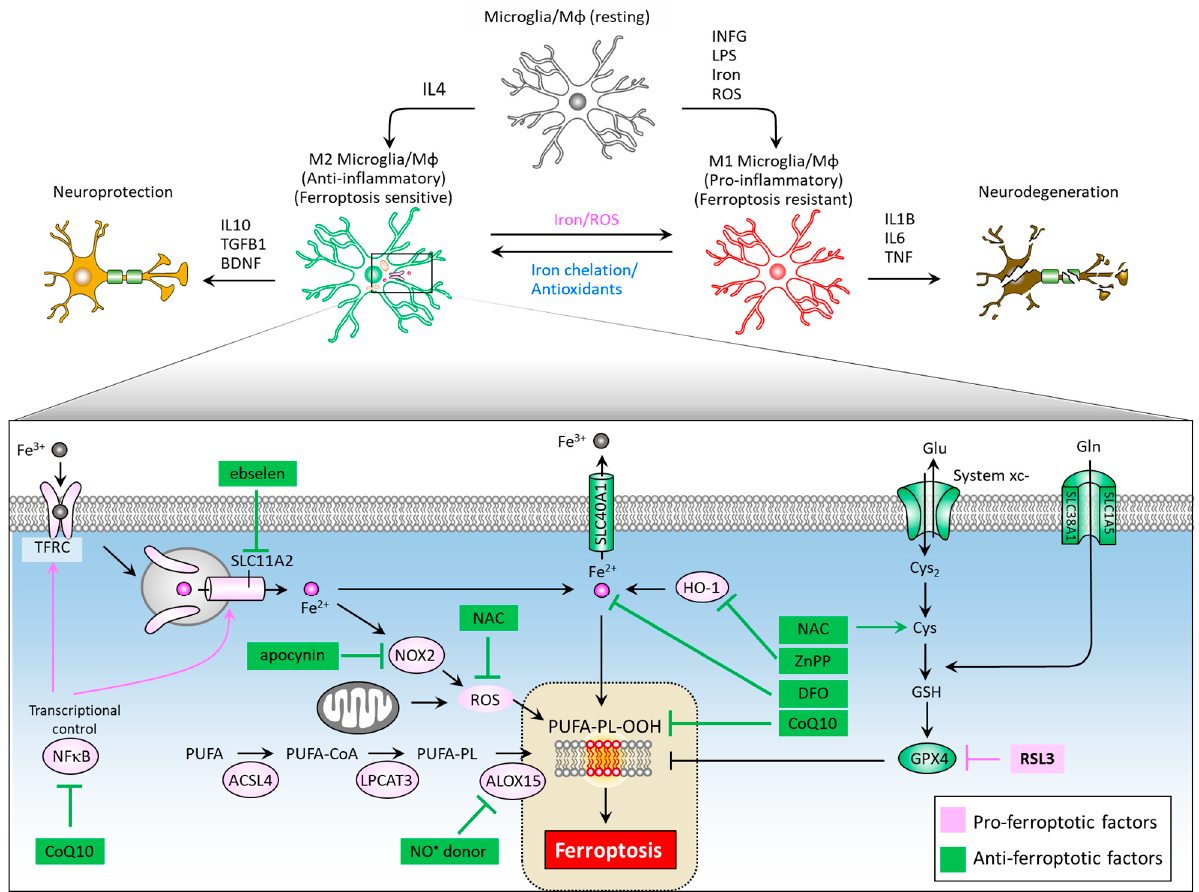
Figure 4. Ferroptosis-associated molecules at the crossroad of microglia/macrophage M1/M2 polarization and neuroin- flammation. While M1 microglia feature ferroptotic resistance, M2 microglia are vulnerable to ferroptosis. Therapeutic targets to reduce iron accumulation, scavenge ROS, and impede the formation of lipid peroxides could provide new hope in the treatment of PD and neurodegenerative disorders. ACSL4, acyl-CoA synthetase long chain family member 4; ALOX15, arachidonate 15-lipoxygenases; BDNF, brain derived neurotrophic factor; CoQ10, coenzyme Q10; Cys, cysteine; Cys2, cystine; DFO, desferoxamine; DHO, dihydroorotate; DHODH, dihydroorotate dehydrogenase; Gln, glutamine; Glu, glutamate; GPX4, glutathione peroxidase 4; GSH, glutathione; HO-1, heme oxygenase-1; IFNG, interferon gamma; IL1B, interleukin-1 beta; IL4, interleukin-4; IL10, interleukin-10; LPS, lipopolysaccharide; M ϕ , macrophage; NAC, N-acetylcysteine; NF κ B, nuclear factor kappa B; NOX2, NADPH oxidase 2; PUFA-PL-OOH, lipid peroxides generated from polyunsaturated fatty acid-containing phospholipids; ROS, reactive oxygen species; SLC1A5, solute carrier family 1 member 5; SLC3A2, solute carrier family 3 member 2; SLC11A2, solute carrier family 11 member 2; SLC40A1, solute carrier family 40 member 1; SLC7A11, solute carrier family 7 member 11; TFRC, transferrin receptor; TGFB1, transforming growth factor beta